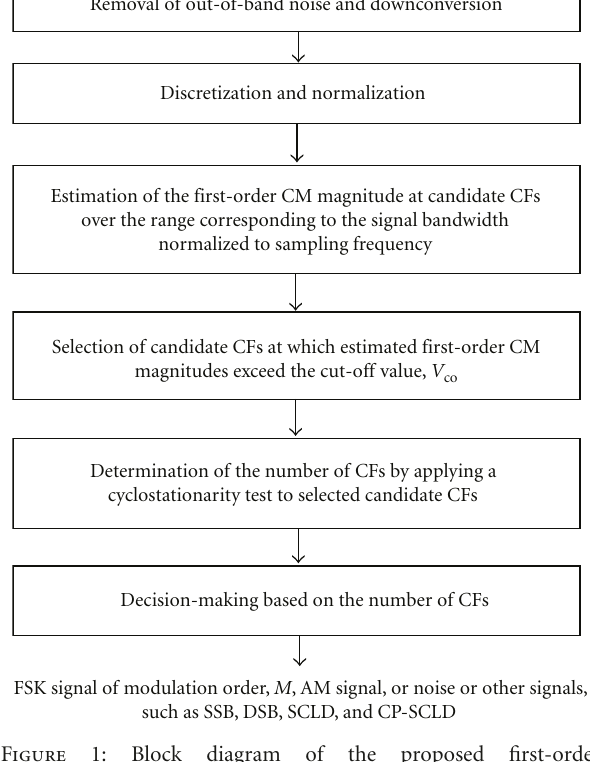
Figure 1: Block diagram of the proposed first-order cyclostationarity-based joint detection and classification